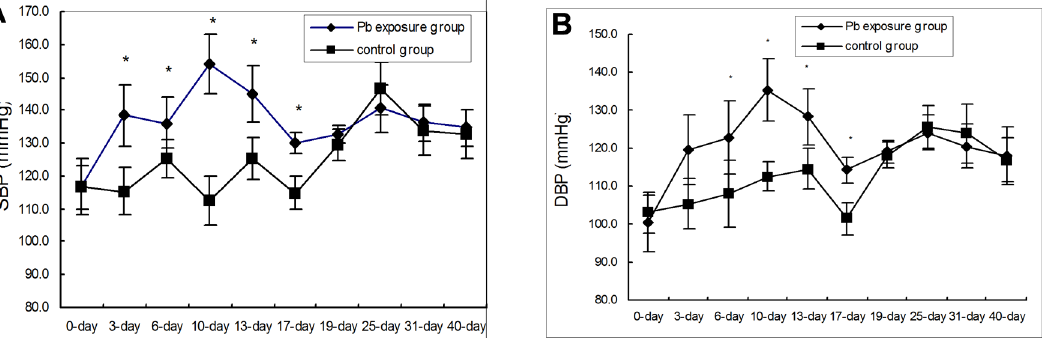
Fig 1. Effect of Pb exposure on blood pressure. A. Effects of Pb exposure on systolic blood pressure. B. Effects of Pb exposure on diastolic blood pressure. n = 6 Data are the means ± SD. * p < 0.05 compared with the control group